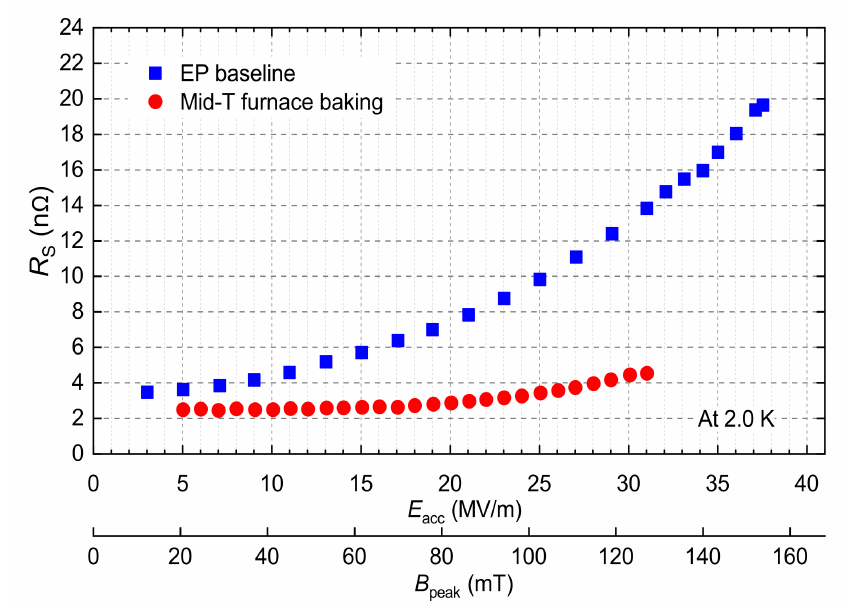
Figure 2. Surface resistance ( R S ) of 650 MHz SRF cavity (Blue: processed with EP; Red: processed with mid-T furnace baking).